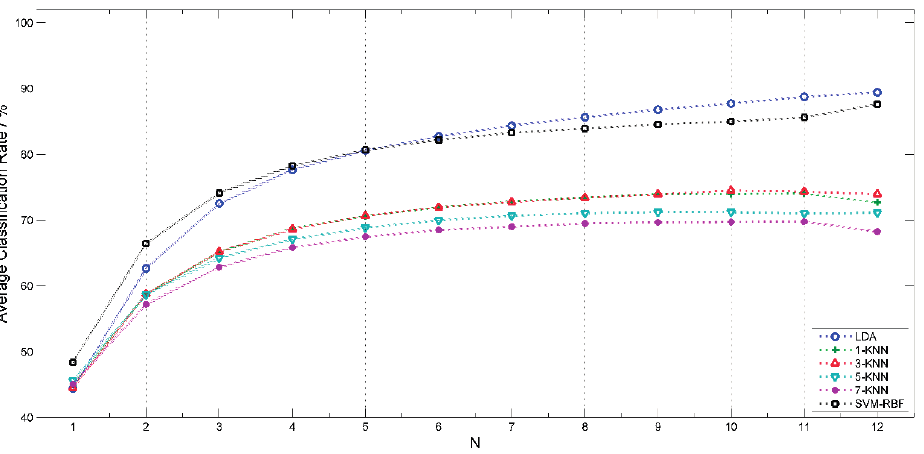
Figure 3. Comparison of average classification accuracy of sensor sets with N ( N = 1 to 12) sensors for LDA, SVM and KNN ( k = 1, 3, 5,